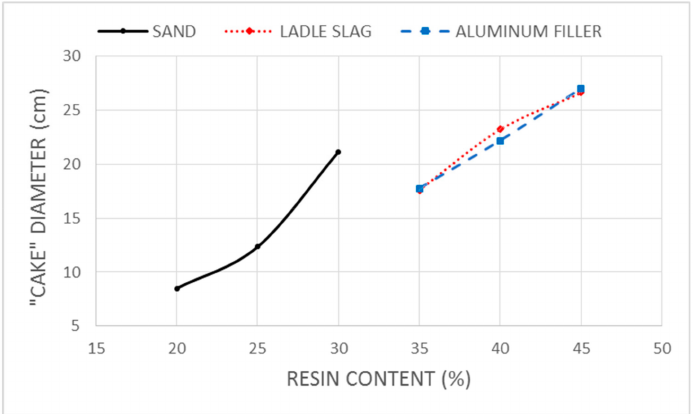
Figure 2. Resin dosage intervals and consistency test results.